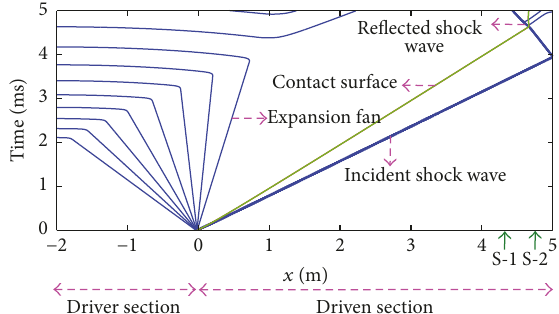
Figure 5: Representation of shock tube operating conditions in x-t